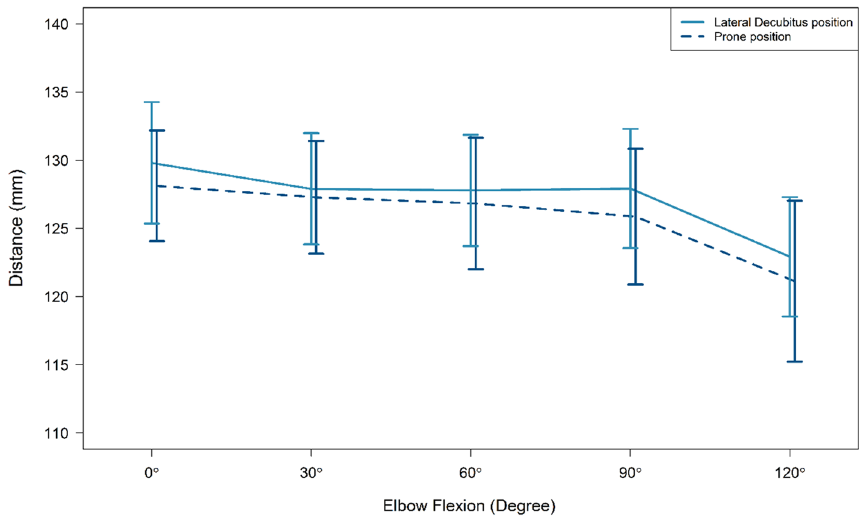
Figure 1. A line graph showing the distance from the upper part of the olecranon to the center of the radial nerve in each